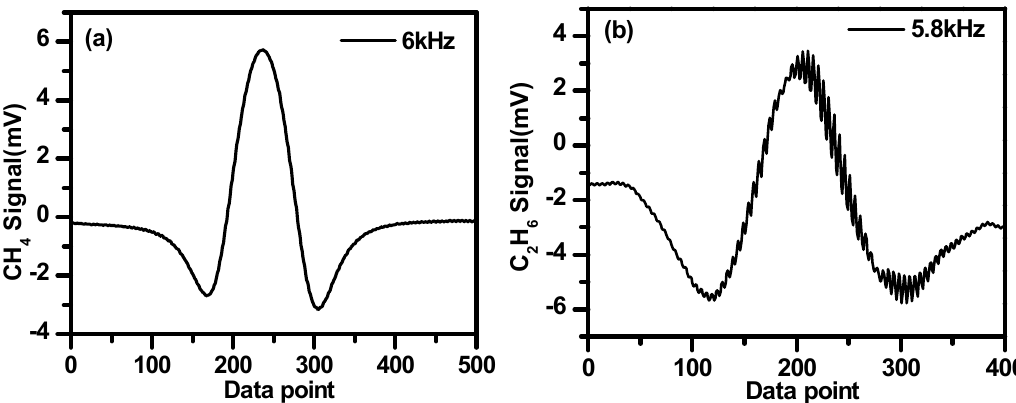
Figure 8. Second harmonic signals of CH 4 modulated at 6 kHz ( a ) and C 2 H 6 modulated at 5.8 kHz ( b ) showing cross-talk induced interference fringes superimposed on the second harmonic signal.